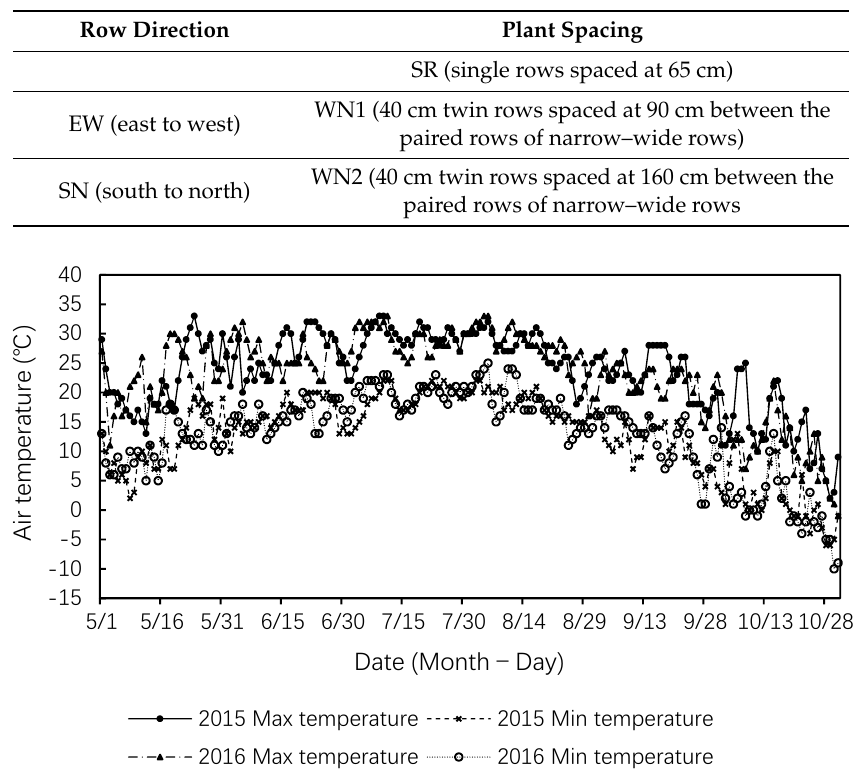
Figure 1. Max and min air temperatures from 1 May to 30 October in 2015 and 2016. Table 1. The experiment design.